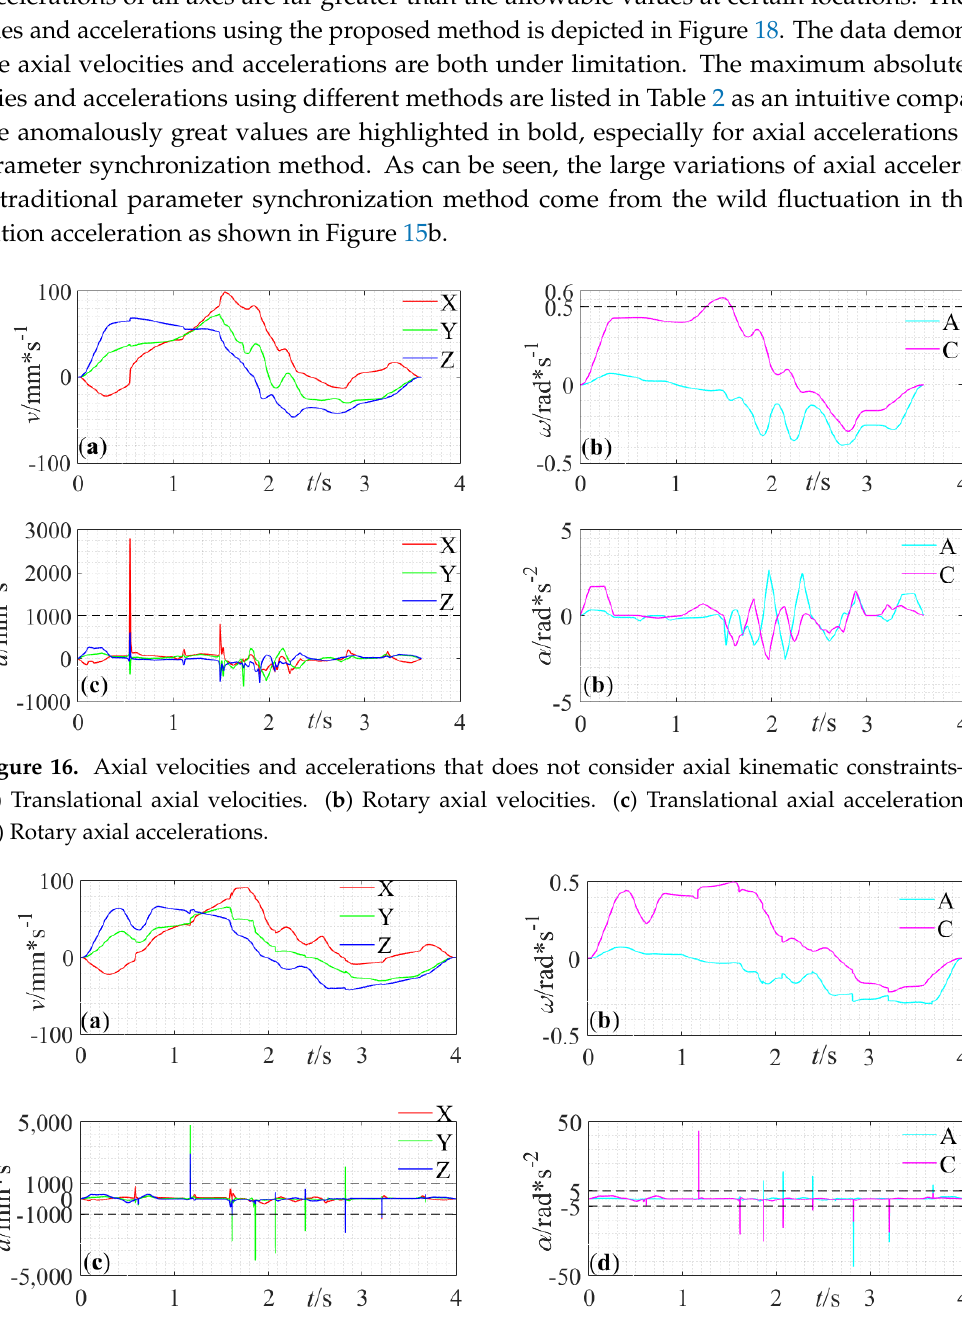
Figure 17. Axial velocities and accelerations using parameter synchronization—( a ) Translational axial velocities. ( b ) Rotary axial velocities. ( c ) Translational axial accelerations. ( d ) Rotary axial